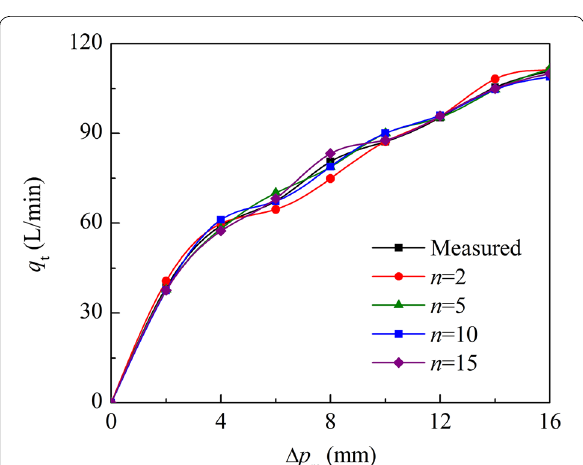
Figure 8 Comparisons between the inferred data and the measured data in case 2